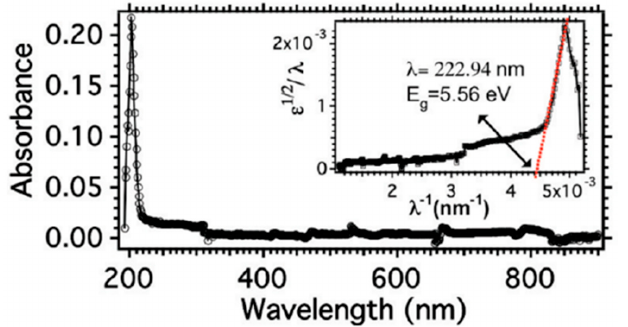
Figure 16. UV − visible absorption spectra of hBN fi lms at room temperature. (Reprinted with permission from ref. [189]. Copyright 2010 American Chemical Society Publications).